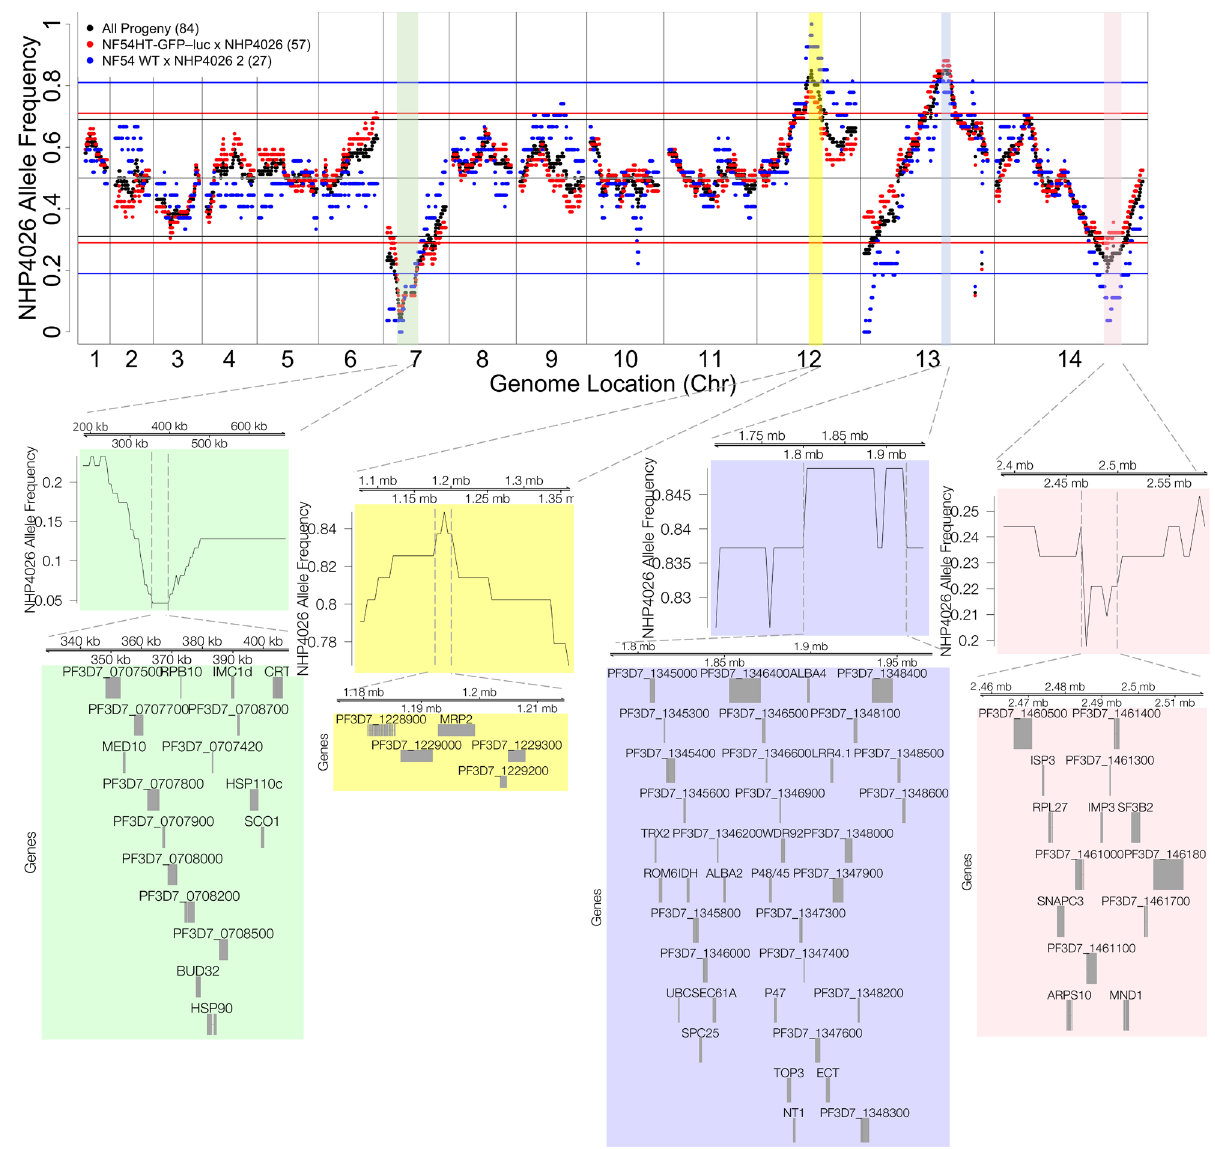
Fig. 4 Replicated segregation distortion in the NF54× NHP4026 cross. Frequency of the NHP4026 SNP alleles in unique recombinant progeny in NF54 × NHP4026 is highly repeatable across biological replicates (black — all progeny, red — progeny from biological replicate 1, blue — progeny from biological replicate 2). Horizontal lines represent signi fi cance thresholds ( χ 2 test p = 0.001) for segregation distortion for each corresponding set of progeny. Colored regions (green, yellow, lilac, pink) show signi fi cant segregation distortion in both biological replicates. Genes are shown for the peak regions of segregation